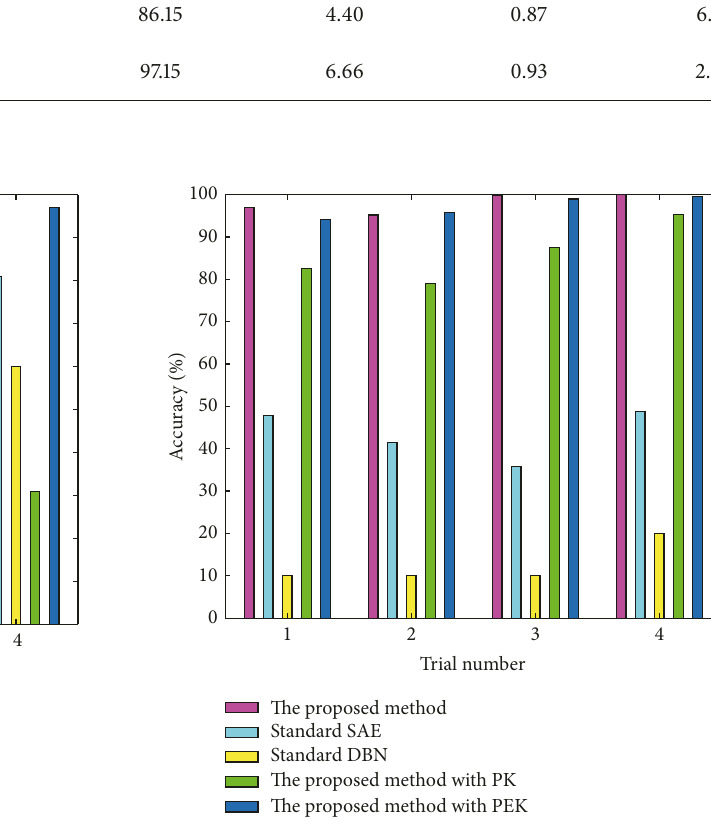
Figure 7: Detailed diagnosis results of the 4 trials in Experiment 2. Figure 8: Detailed diagnosis results of the 4 trials in Experiment